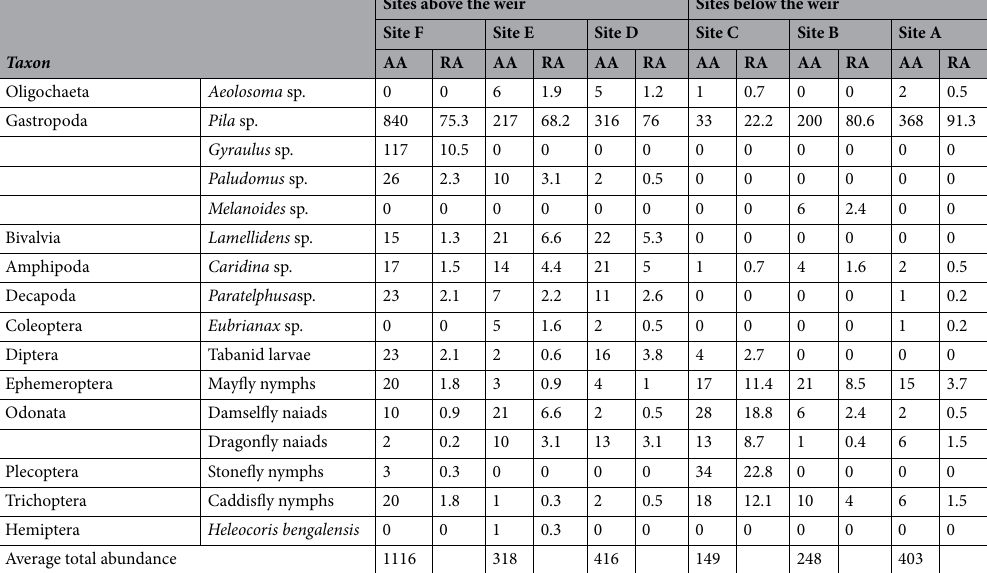
Table 3. The overall average composition (AA = absolute abundance—n. individuals, RA = relative abundance—%) and distribution of benthic macroinvertebrate communities in the Gurugoda Oya, above (sites